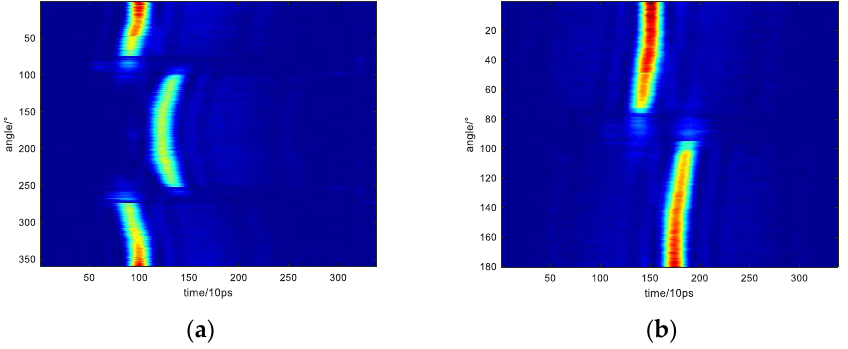
Figure 6. ( a ) Laser reflection projection data after registration; ( b ) converted projection data in complete angle.